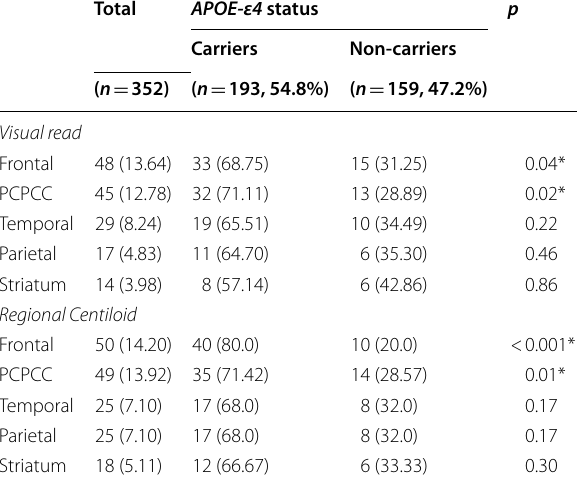
Data are expressed as number of participants and percentage PCPCC Precuneus/posterior cingulate